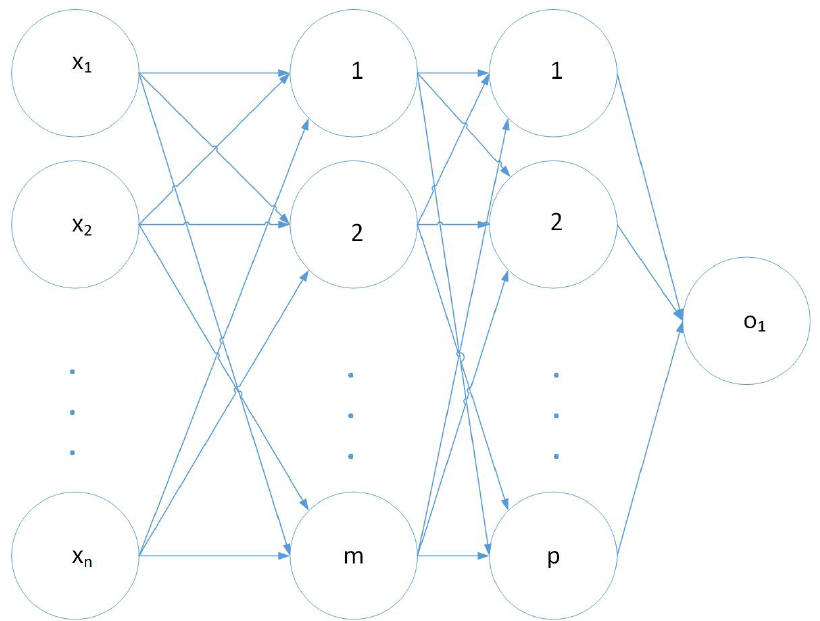
Figure 1. Feed forward neural network